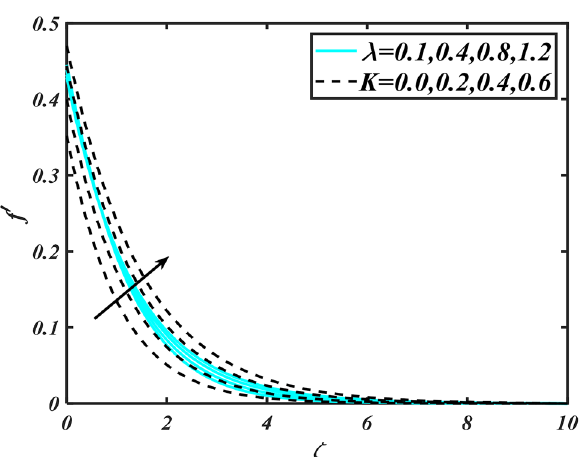
Figure 5. Aspects of (cid:31) & K versus f ′ .